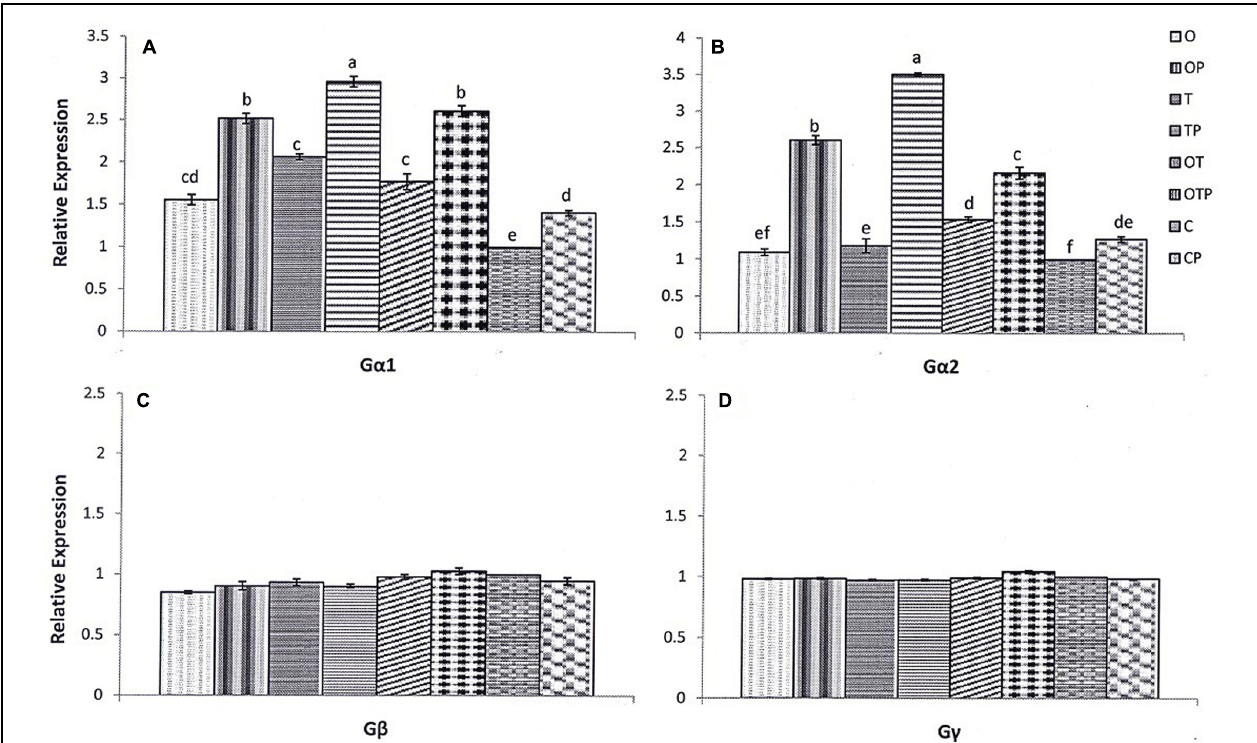
FIGURE 1 | Relative transcript accumulation pattern of pea heterotrimeric G-protein subunits [G α 1 (A) and 2 (B), G β (C) and G γ (D)] as analyzed through quantitative real time-PCR in different treatments after 24 h of pathogen ( Erysiphe pisi ) challenge: O- Pseudomonas fluorescens OKC; OP- OKC treated and pathogen challenged; T - Trichoderma asperellum T42; TP- T42 treated and pathogen challenged; OT- combination of OKC and T42; OTP- OKC and T42 treated and pathogen challenged; P- Pathogen challenged and C- OKC and T42 non-treated and pathogen unchallenged control. The qRT-PCR data were normalized with mean CT value of the endogenous gene ubiquitin and fold accumulation of transcripts was compared by using the mean of the CT values of the three biological replicates with treatment C (control). Error bars represent SD (Standard Deviation) from means of three measurements. Different superscript letters indicate data significantly different from the other treatments ( P ≤ 0.05; Duncan’s multiple range